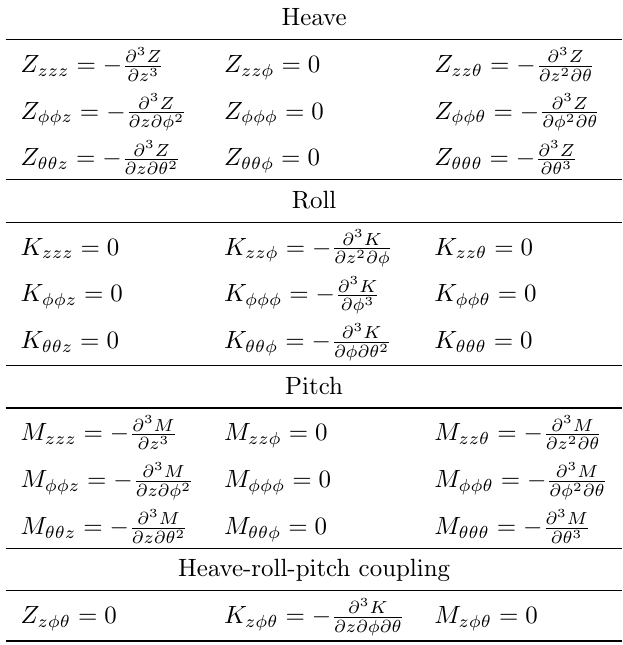
Table 3: 3 rd -order hydrostatic restoring coefficients